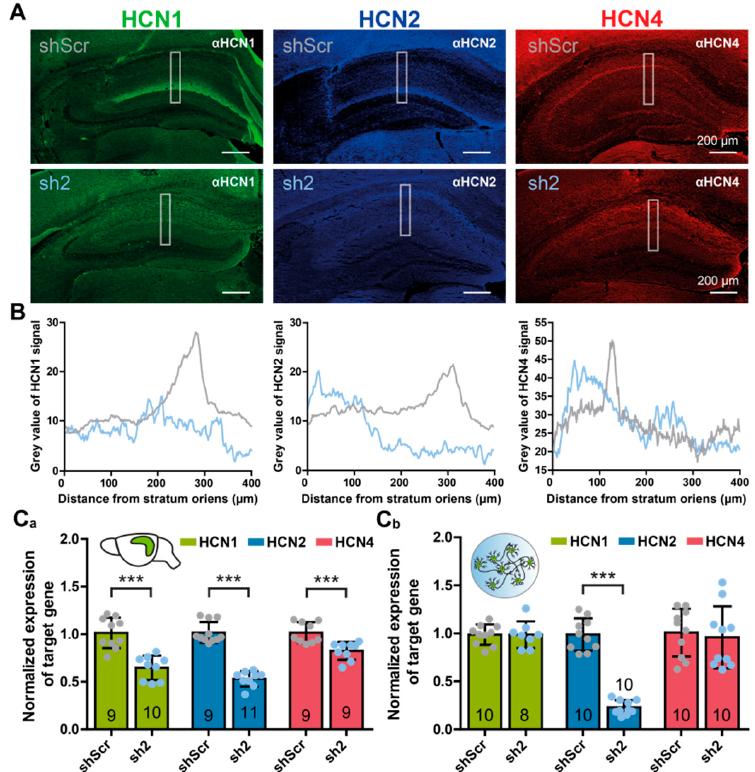
Figure 4. HCN isoform expression changes after loss of HCN2. ( A ) Representative immunofluorescent images showing expression of HCN-channel isoforms 1 (green), 2 (blue), and 4 (red) in rAAV9-shScr- (upper panel) or rAAV9-sh2 (lower panel)-injected hippocampi. Isoforms were stained using subunit-specific antibodies combined with fluorescently labeled secondary antibodies. White rectangles indicate region for ( B ) quantification of immunofluorescence intensities of HCN1-, HCN2-, and HCN4-specific staining. Intensities were measured from the stratum oriens of the cornu amonis 1 (CA1) region to the dorsal part of the dentate gyrus (DG) granule cell layer. ( C ) Quantification of transcript levels by qPCR. ( C a ) Quantitative PCR analysis of hcn1 , hcn2 , and hcn4 transcript levels of rAAV-injected brains, and ( C b ) rAAV-treated PHNs. Expression levels were calculated and normalized to shScr-treated controls. Data were obtained from indicated numbers of injected hippocampi, or PHN cultures obtained from at least 3 different animals. Results are depicted as mean ± SD. Statistical significance was assessed using the unpaired two-tailed Student’s t -test, *** p < 0.001.